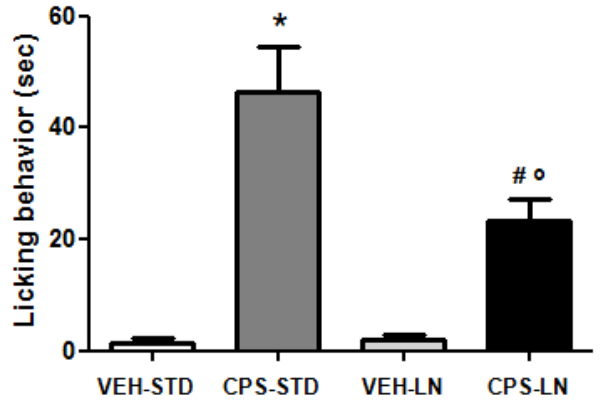
Figure 4. Intraplantar (i.pl.) injection of CPS induces spontaneous pain. The nocifensive response to i.pl. injection of CPS (0.125%/10 µL) dissolved in standard vehicle or included in LN in naïve mice is shown. Data are means ± S.E.M of 6 mice, and refer to the number of sec spent in licking behavior in